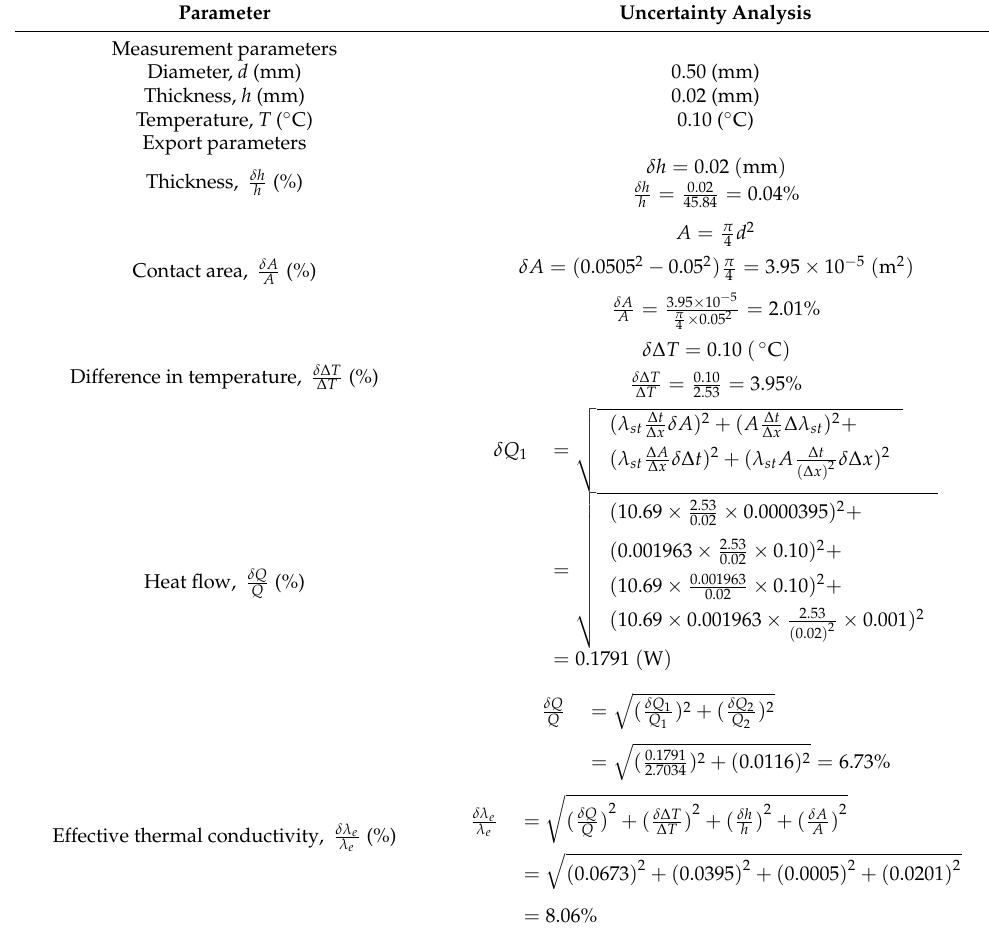
Table 2. Uncertainty analyses of the